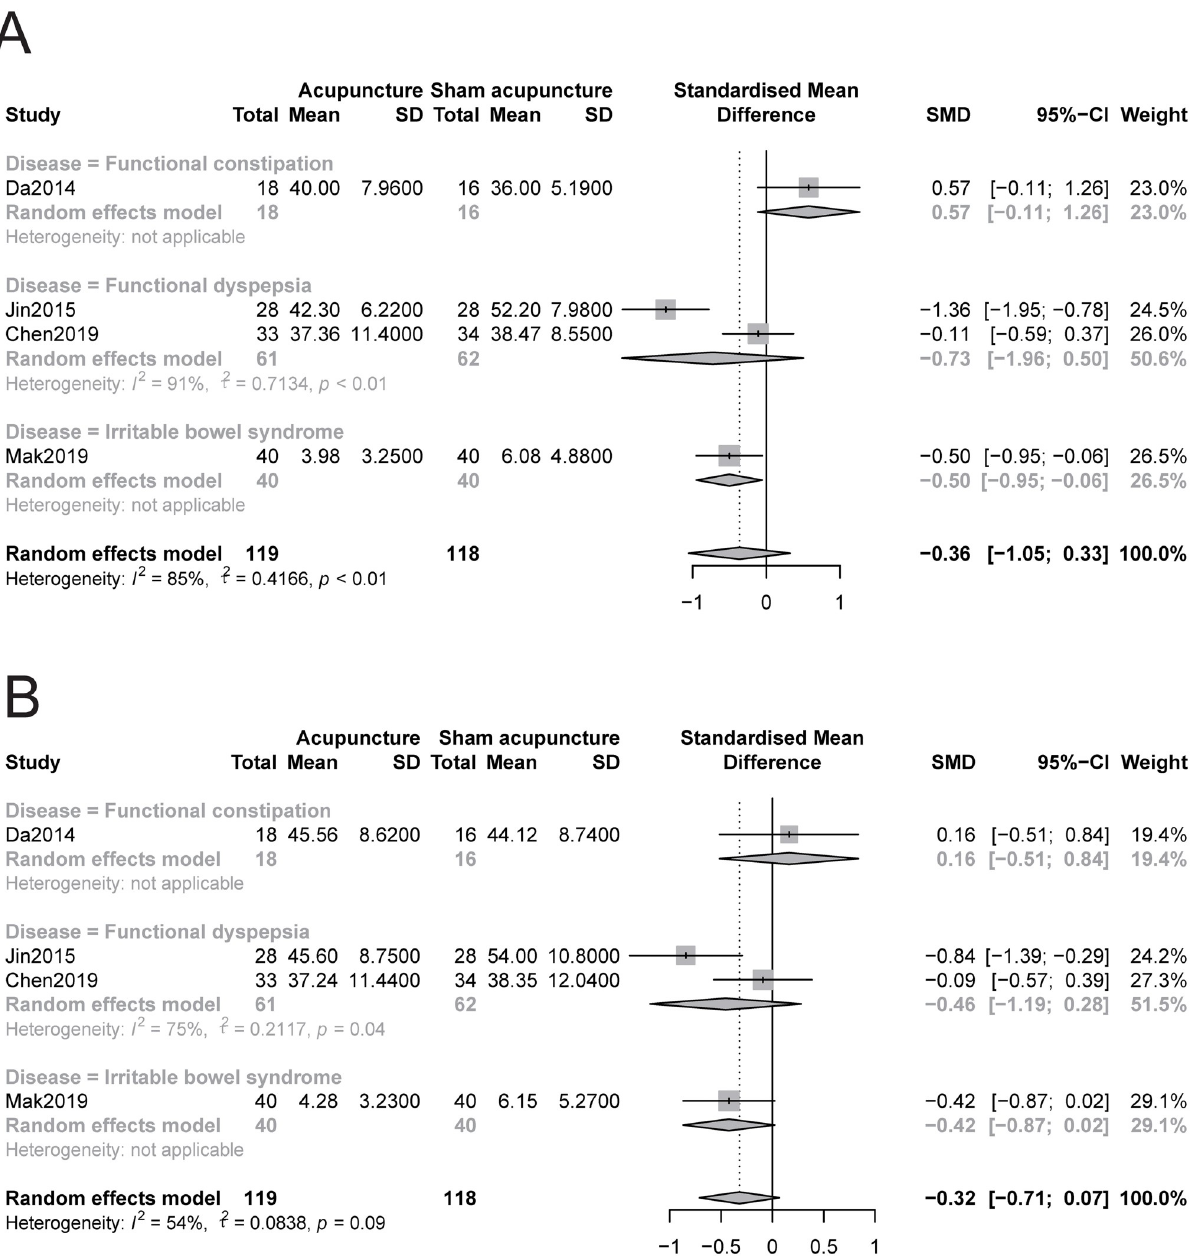
Fig 2. Forest plot of comparison: Acupuncture versus sham acupuncture, outcome: Severity of anxiety and depression at the end of treatment. A: anxiety, B: depression.